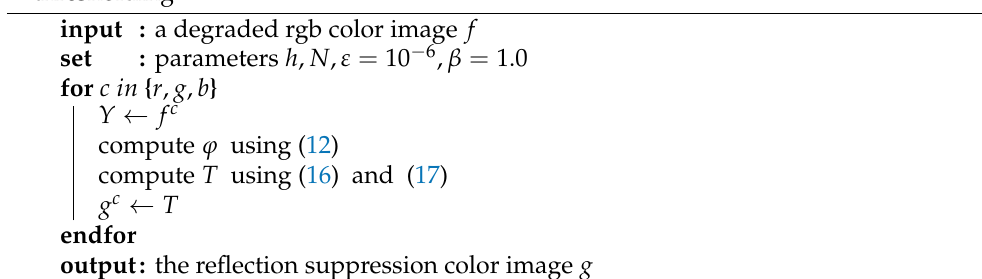
Algorithm 1: The proposed algorithm for reflection suppression by multiscale